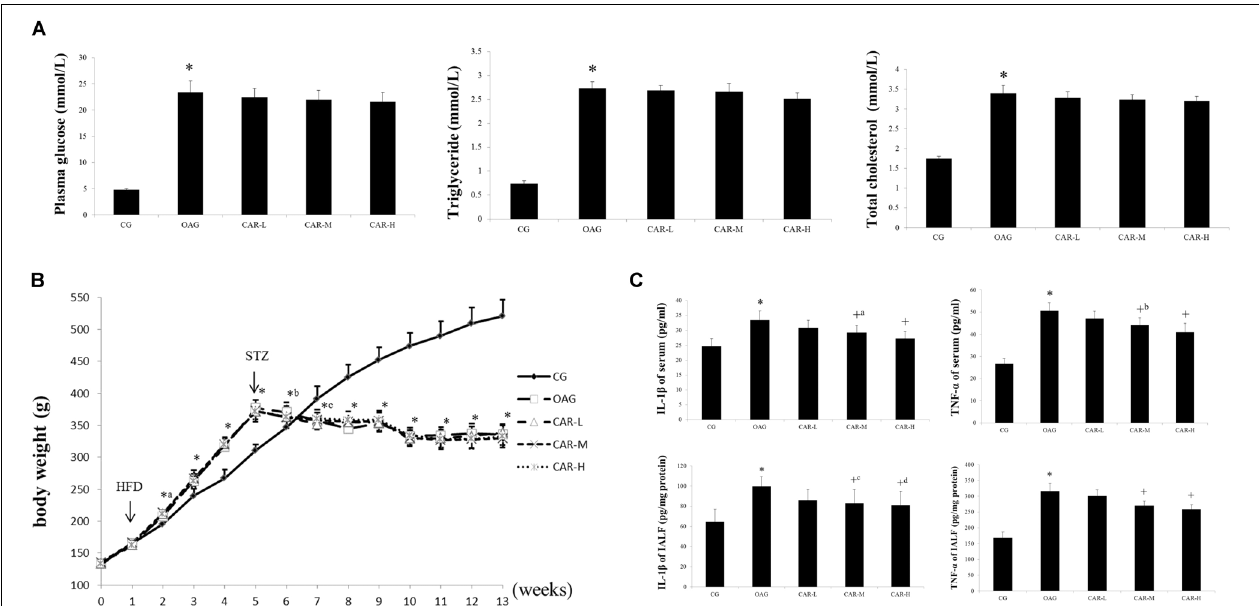
FIGURE 3 | The results of body weight, serum, and intra-articular lavage fluid (IALF). (A) The results of plasma glucose, triglycerides, and total cholesterol. The differences between the CG and OAG were significant ( ∗ P < 0.001), but no significant differences were observed between OAG and CAR-L, CAR-M, or CAR-H. (B) Body weights. Differences between the CG and OAG were significant ( ∗ P < 0.001, ∗ a P = 0.002, ∗ b P = 0.030, and ∗ c P = 0.001), but no significant differences were observed between OAG and CAR-L, CAR-M, or CAR-H. (C) Serum and IALF IL-1 β and TNF- α levels. Differences between the CG and OAG were significant ( ∗ P < 0.001), and differences between the OAG group and CAR-L, CAR-M, and CAR-H were significant ( + P < 0.001, + a P = 0.013, + b P = 0.002, + c P = 0.022, and + d P = 0.011). One-way ANOVA, n = 10 or 11 rats for each group; means with 95% confidence